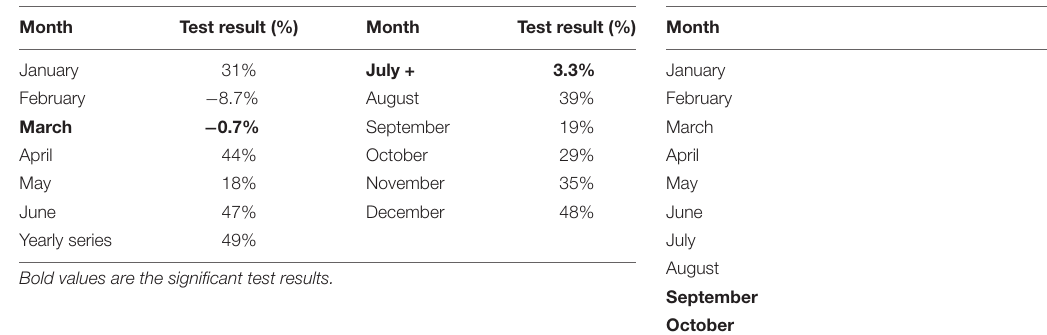
TABLE 3 | Mann-Kendall trend test results. TABLE 4 | Chi square test results for Gumbel fitting.